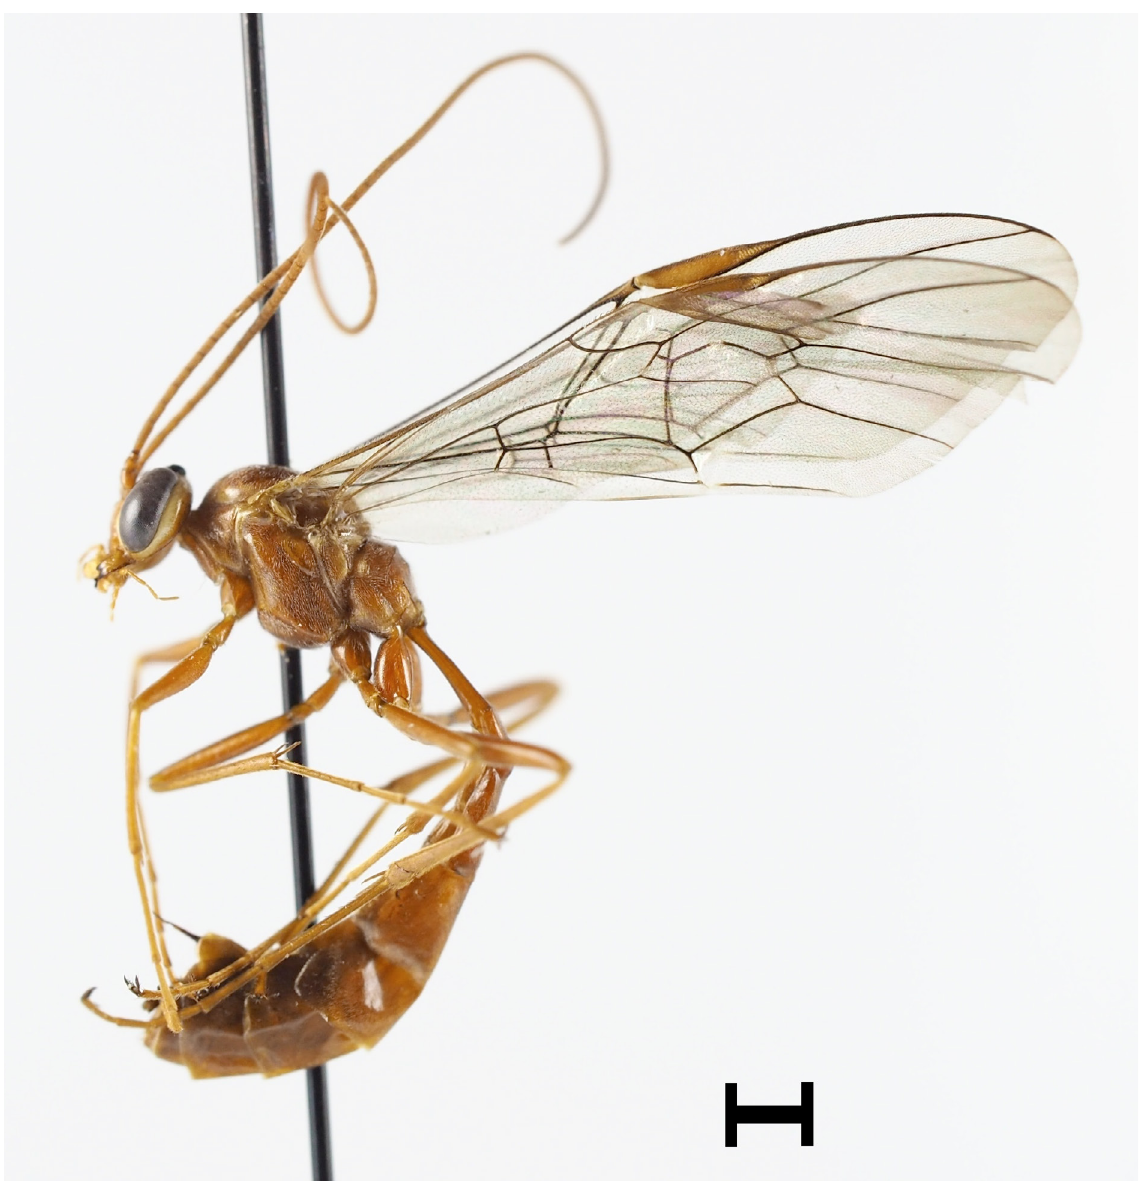
Fig. 43. Ophion sylvestris Johansson sp. nov., paratype, ♀ (NHRS-HEVA000008721). Scale bar = 1